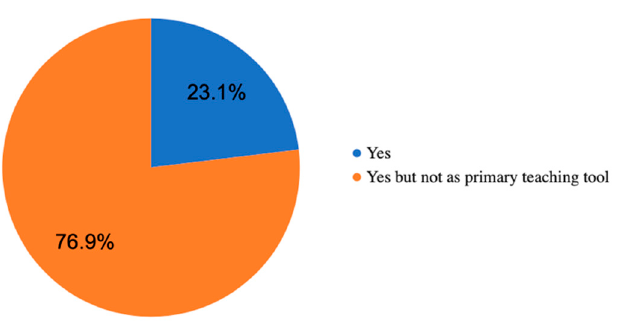
Figure 4. Use of the mobile application during their University of the Third Age (U3V) studies.